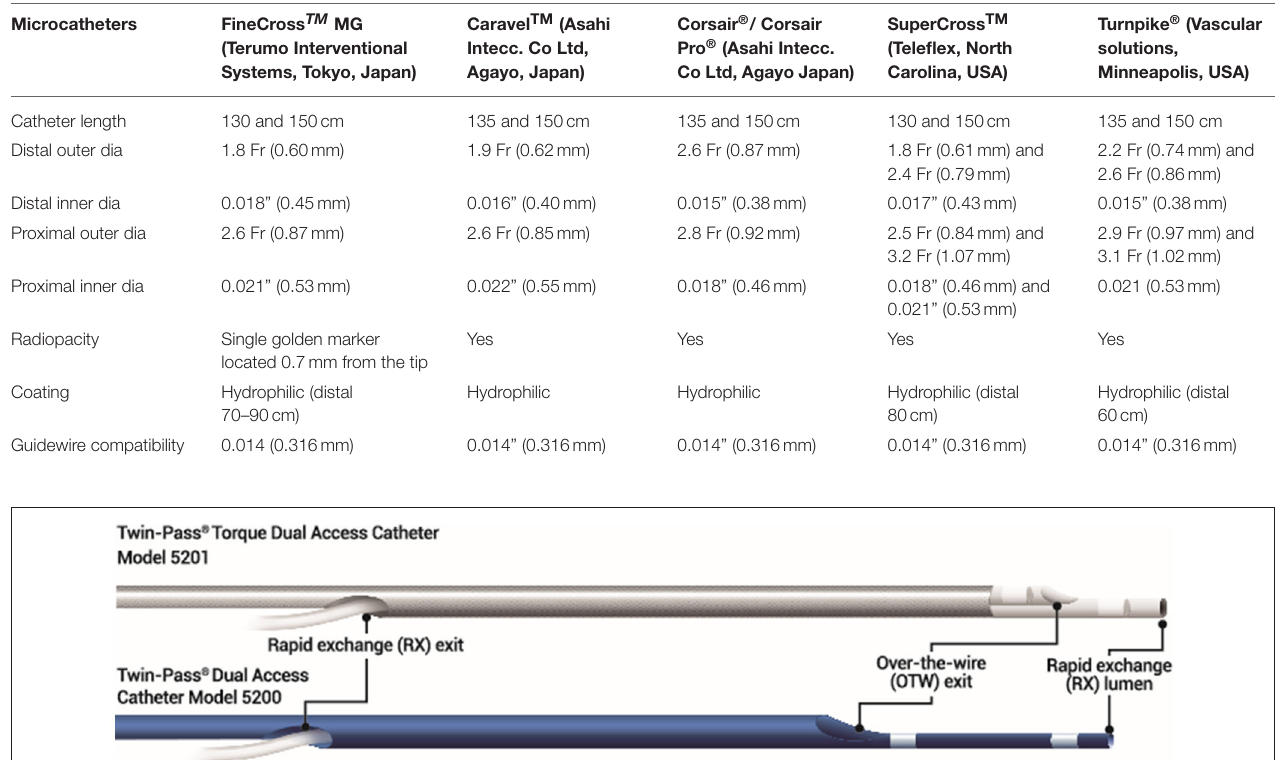
TABLE 1 | A brief comparative table outlining the specific mechanical features of various single-lumen microcatheters. Microcatheters